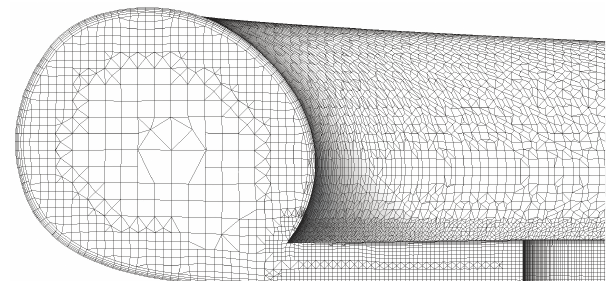
Figure 7: Slice of the unstructured hexahedral-dominant mesh with prism layers automatically generated using snappyHexMesh at the volute exit.